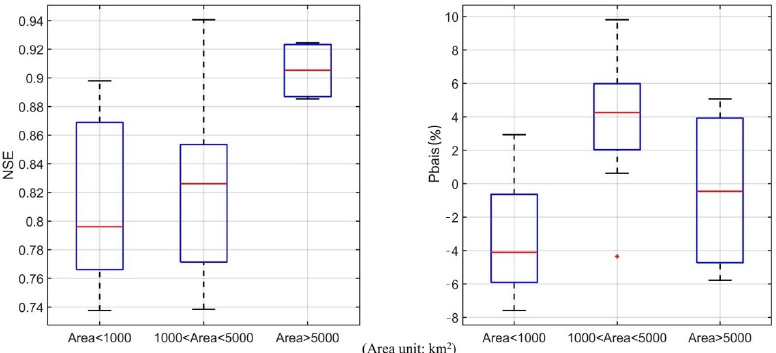
Figure 7. Comparison of simulated and measured monthly runoff at LQ Station.